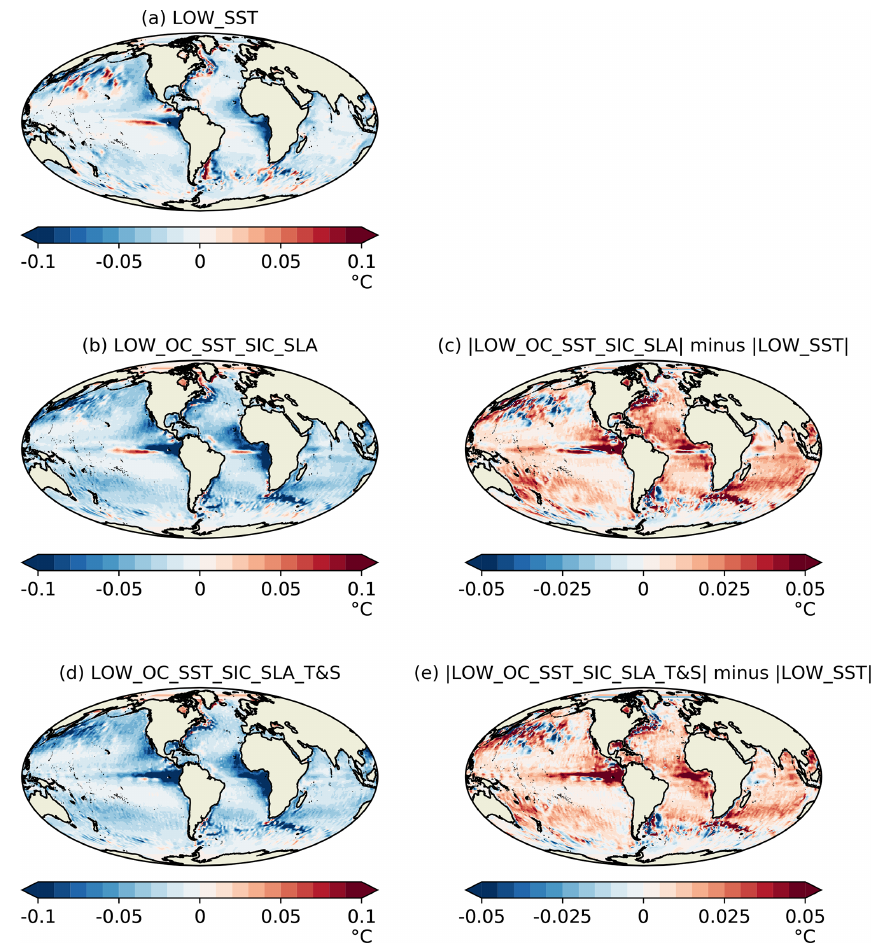
Figure 3. Mean SST assimilation increments for